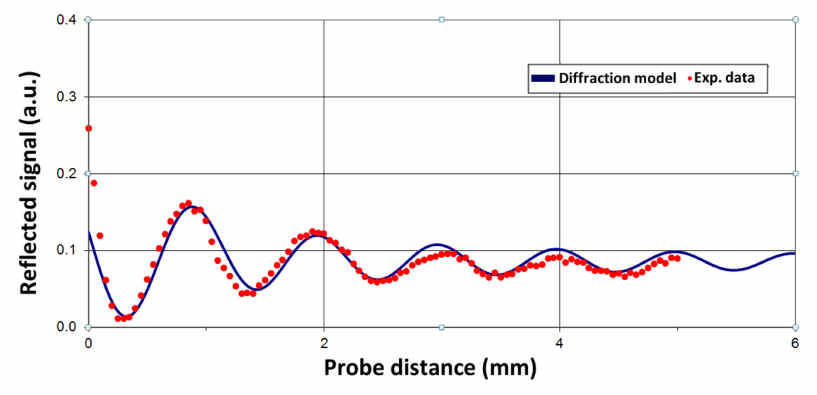
Figure 5. Experimental data for blue cobalt oil (BCO) (dots) and best fit